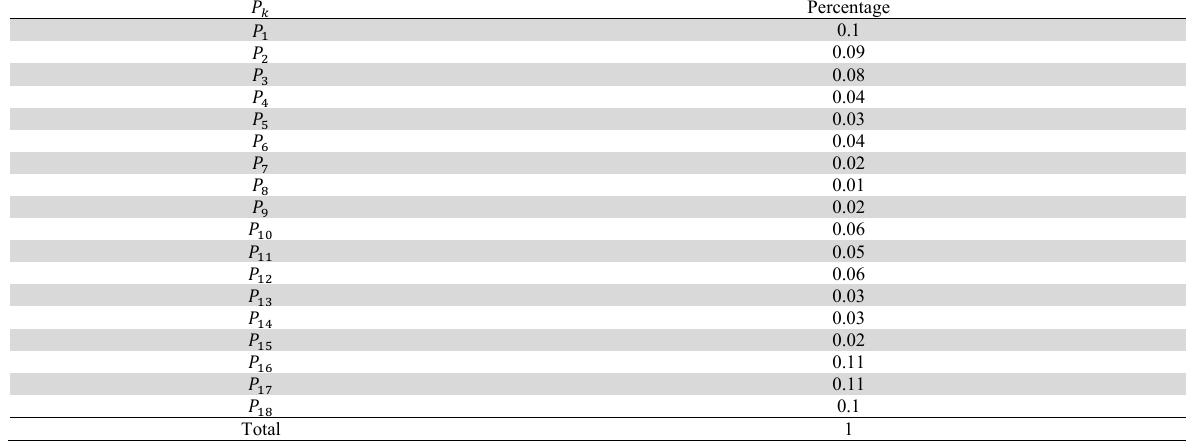
Percentage of People Who Participate in Training Programs